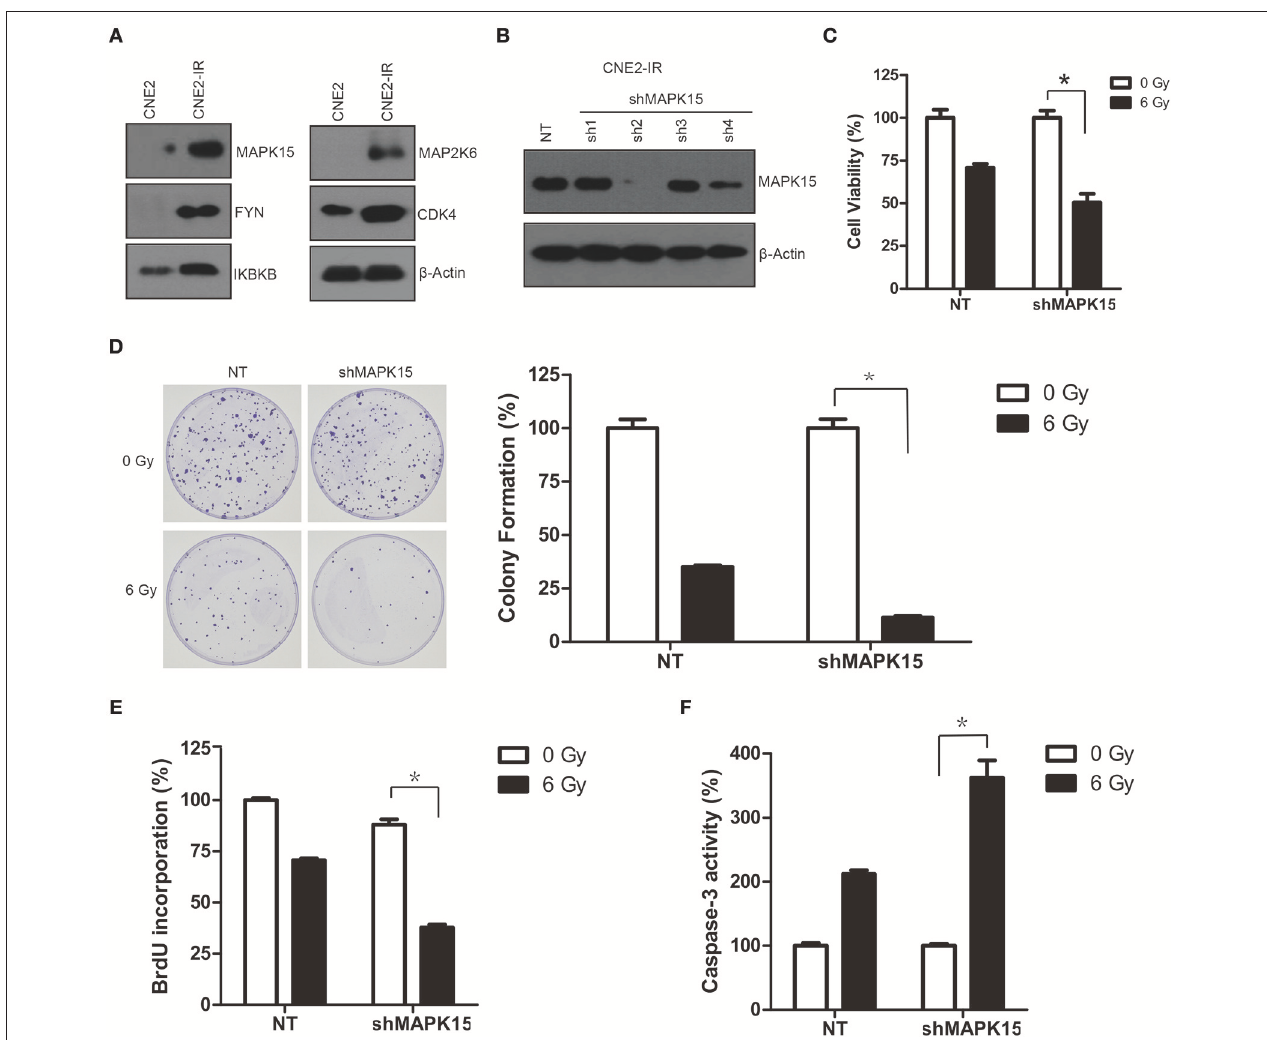
FIGURE 5 | High protein levels of MAPK15 regulate the radiosensitivity in CNE2-IR cells. (A) Western blotting validation on protein levels of five protein kinases (MAPK15, FYN, IKBKB, MAP2K6, and CDK4) in CNE2 and CNE2-IR cells. β -actin served as a loading control. (B) MAPK15 protein expression was significantly reduced in CNE2-IR cells transduced with shMAPK15 lentivirus (sh4). (C) Knockdown of MAPK15 increased radiosensitivity in CNE2-IR cells. The cell viability in NT or shMAPK15 without ionizing irradiation was regarded as 100%, respectively. shMAPK15 (6Gy) vs. NT (6Gy), n = 3 * P < 0.05. (D) Knockdown of MAPK15 attenuated colony formation after irradiation in CNE2-IR cells. The colony formation in NT or shMAPK15 without ionizing irradiation was regarded as 100%, respectively. shMAPK15 (6Gy) vs. NT (6Gy), n = 3, * P < 0.05. (E) Knockdown of MAPK15 impaired the proliferative potential of CNE2-IR cells exposed to irradiation. The BrdU incorporation in NT without ionizing irradiation was regarded as 100%. shMAPK15 (6Gy) vs. NT (6Gy), n = 4, * P < 0.05. (F) Knockdown of MAPK15 increased caspase-3 activity following irradiation in CNE2-IR cells. The caspase-3 activity in NT or shMAPK15 without ionizing irradiation was regarded as 100%, respectively. shMAPK15 (6Gy) vs. NT (6Gy), n = 4, * P <